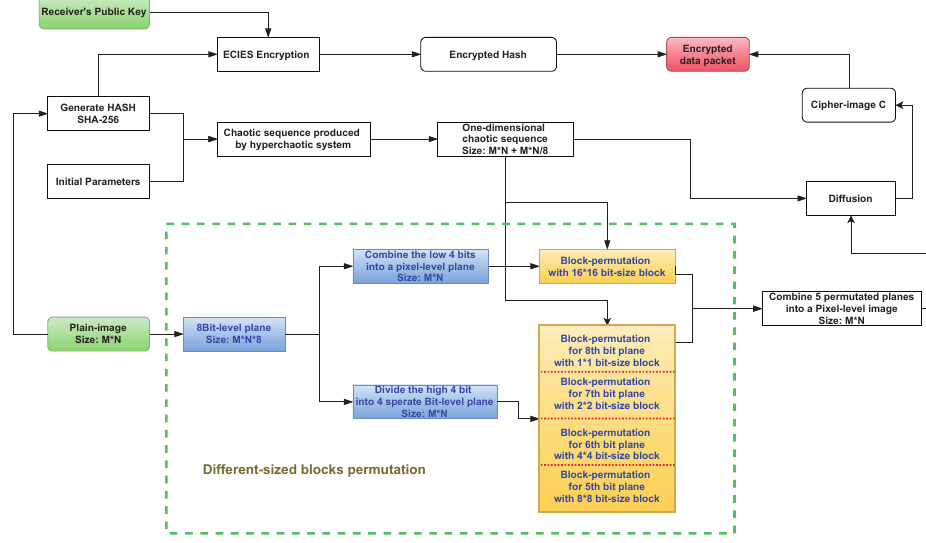
Figure 4. The general flow chart of the